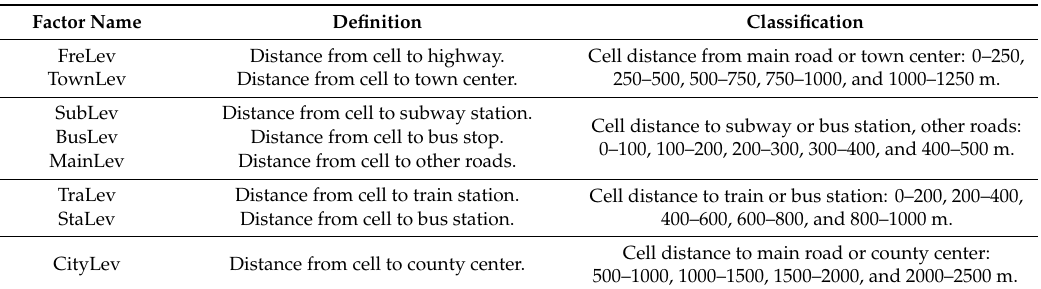
Table 2. Suitability-factor classification.